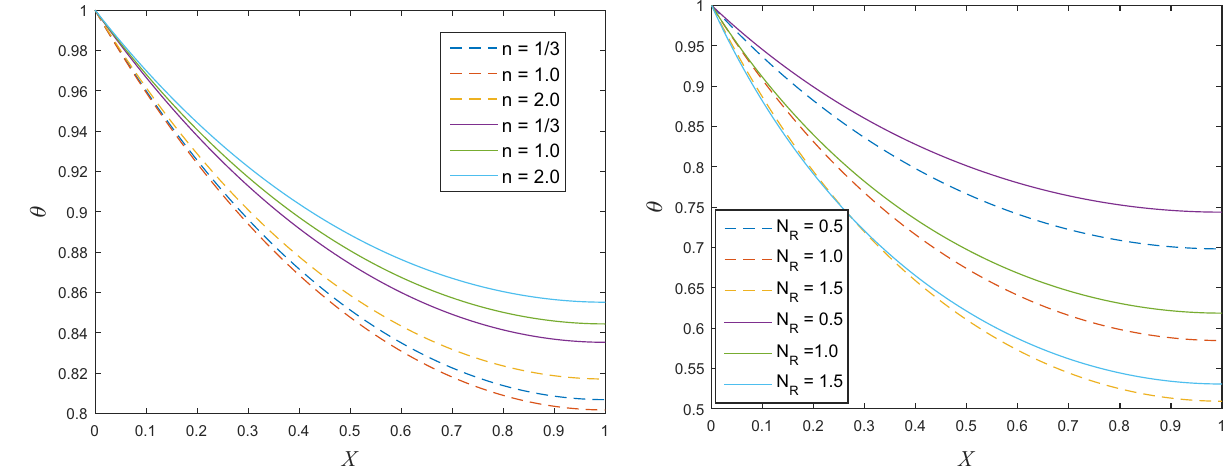
Figure 4: E ff ect of n (- - linear variation and — non - linear variation ) on the temperature distribution of the fi n.